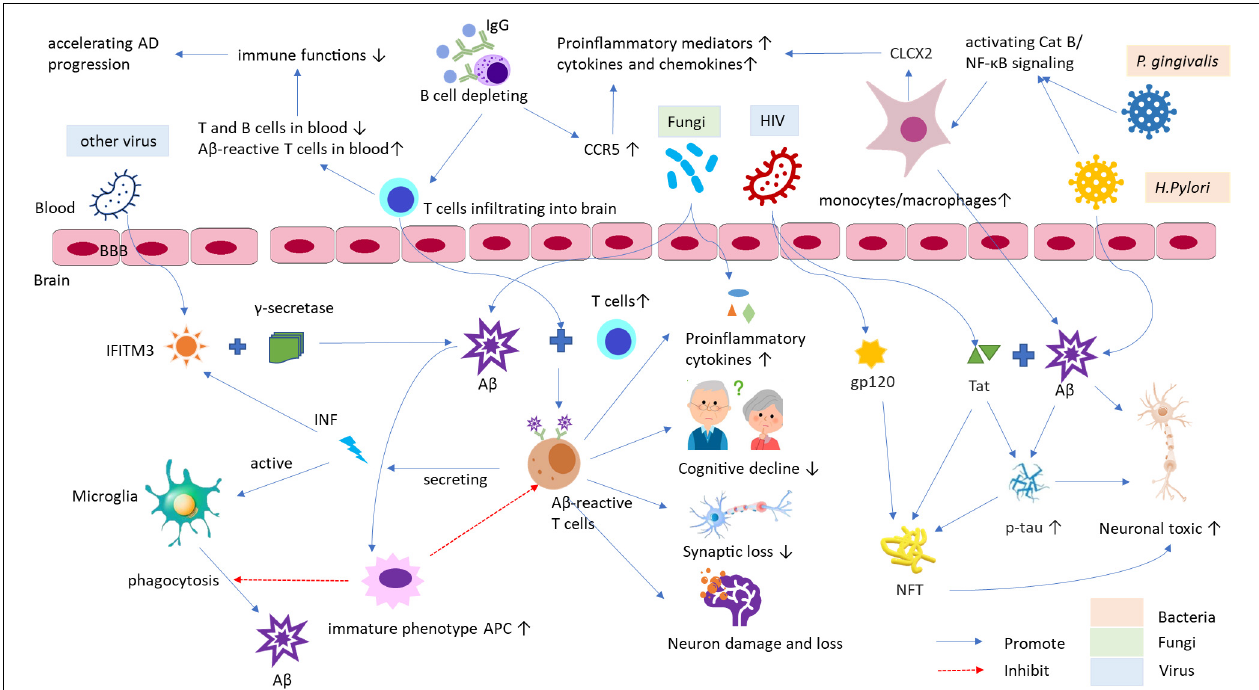
FIGURE 1 | The role of infection and inflammation in the pathogenesis of AD and its animal models. The infections by bacteria, viruses, and other pathogens, and it caused chronic inflammation may be the crucial risk factors for AD development and progress. These pathogens can access into the brain through increased permeability of BBB. Afterward, the viruses active IFITM3 can bind to γ -secretase raising A β accumulation and deposition in brain and act as a mediator in the process of inflammation and A β formation. The bacteria, such as P. gingivalis and H. Pylori , can induce A β accumulation in inflammatory monocytes/macrophages through Cat B/NF- κ B signaling. Activated monocytes/macrophages secrete CXCL2 can increase productions of proinflammatory mediators and cytokines/chemokines, leading to the pathological changes being similar to those of AD, for example, the elevated phospho-tau/tau ratio and synapse loss, etc. HIV and its proteins, such as Tat and envelope glycoprotein gp120, can modulate cellular pathways to deteriorate AD. HIV-Tat can interact with A β and tau via novel protein-protein coaction and induces tau phosphorylation through a cascade of cellular processes to form NFT, eventually resulting in neuronal toxicity. Additionally, fungi can also enter the brain to enhance levels of proinflammatory cytokines and bind to SAP to diminish the phagocytosis of macrophages, which cause A β accumulation, exacerbating AD. Furthermore, infection and inflammation can decline immune function and response contributing the pathogenesis of AD. AD, Alzheimer’s disease; APC, antigen-presenting cell; A β , β -amyloid; BBB, blood-brain barrier; Cat, Cathepsin; CCR5, C chemokine receptor type 5; CNS, central nervous system; CXCL2, chemokine ligand 2; HIV, human immunodeficiency virus; IFITM3, IFN-induced transmembrane protein 3; IFN, interferon; NFT, neurofibrillary tangles; NF- κ B, nuclear factor kappa B; p-tau, phospho-tau; SAP, serum amyloid P component; Tat, trans- activator of